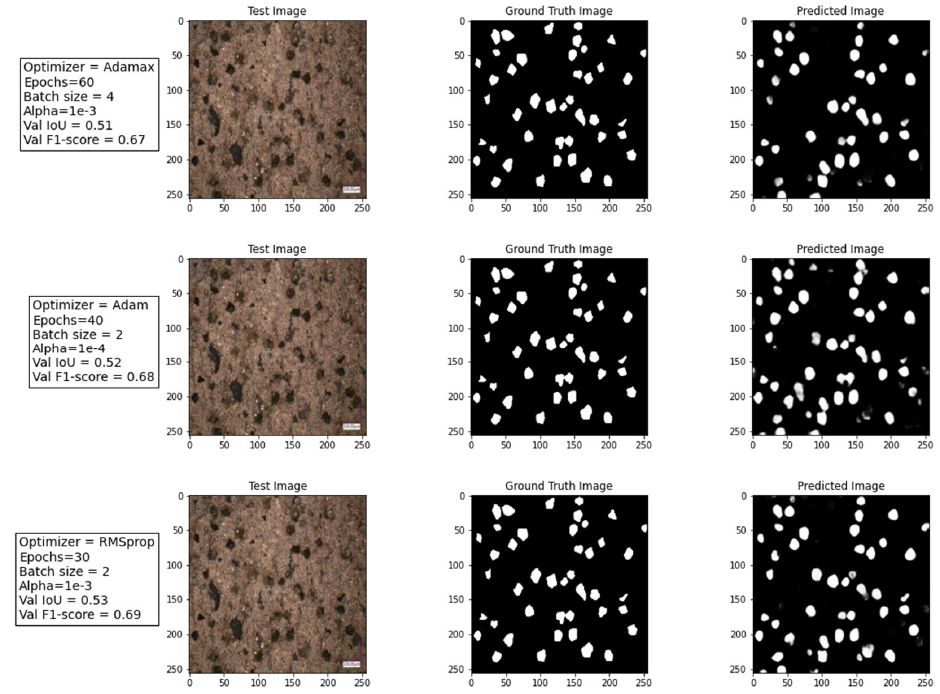
Figure 8. DGW test images of type II, associated mask and prediction for each optimizer.